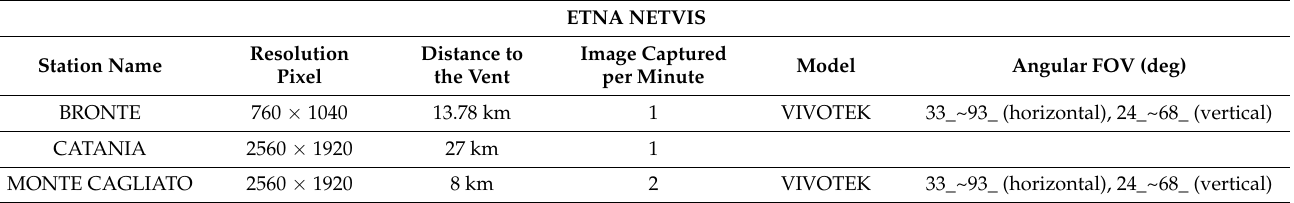
Table 1. Characteristics of the ETNA NETVIS